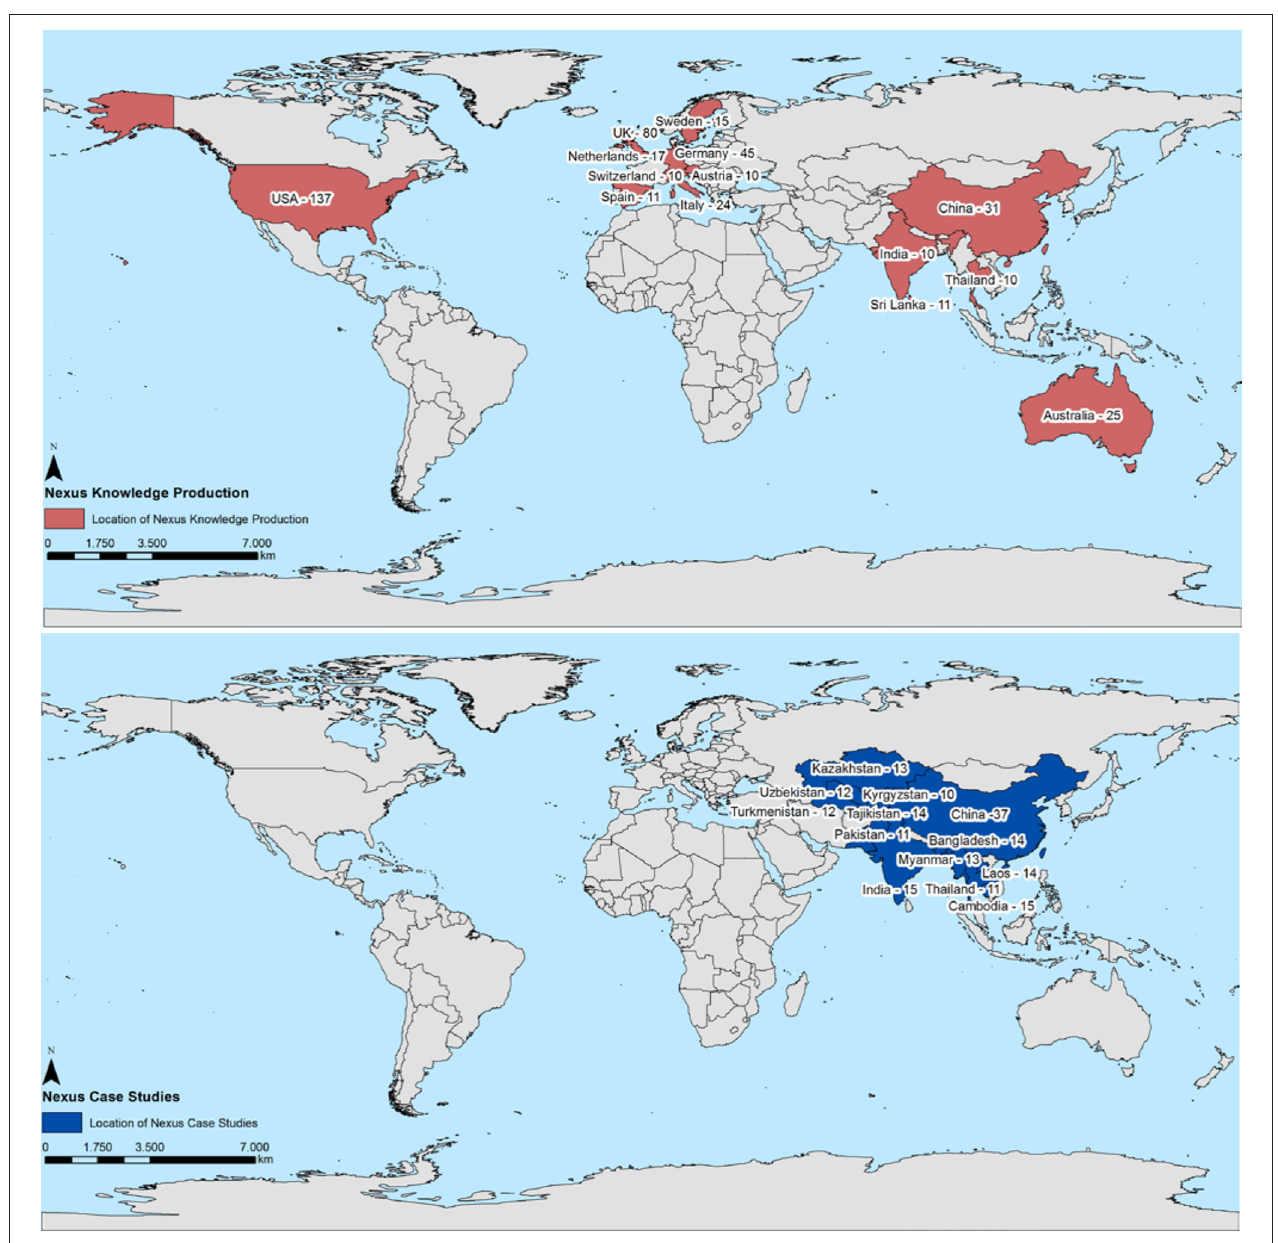
FIGURE 3 | Geographical focus of nexus research and spaces of nexus knowledge production. Map based on places with equal or more than 10